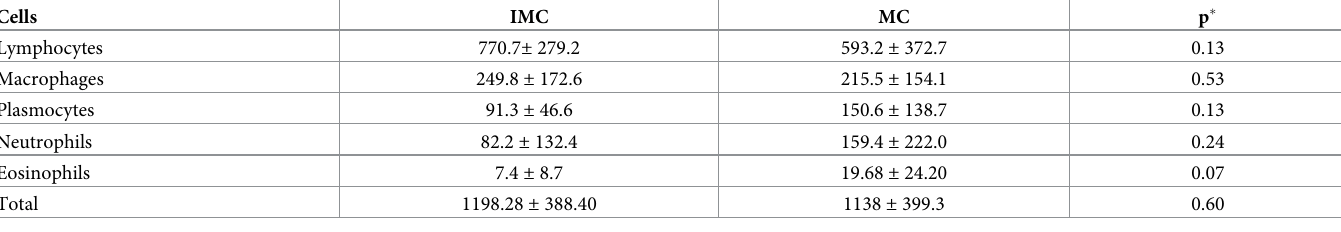
Table 2. Morphometric analysis of the inflammatory tumour infiltrates of female dogs with inflammatory mammary carcinoma or mammary carcinoma (advanced stage). Cells IMC MC p �